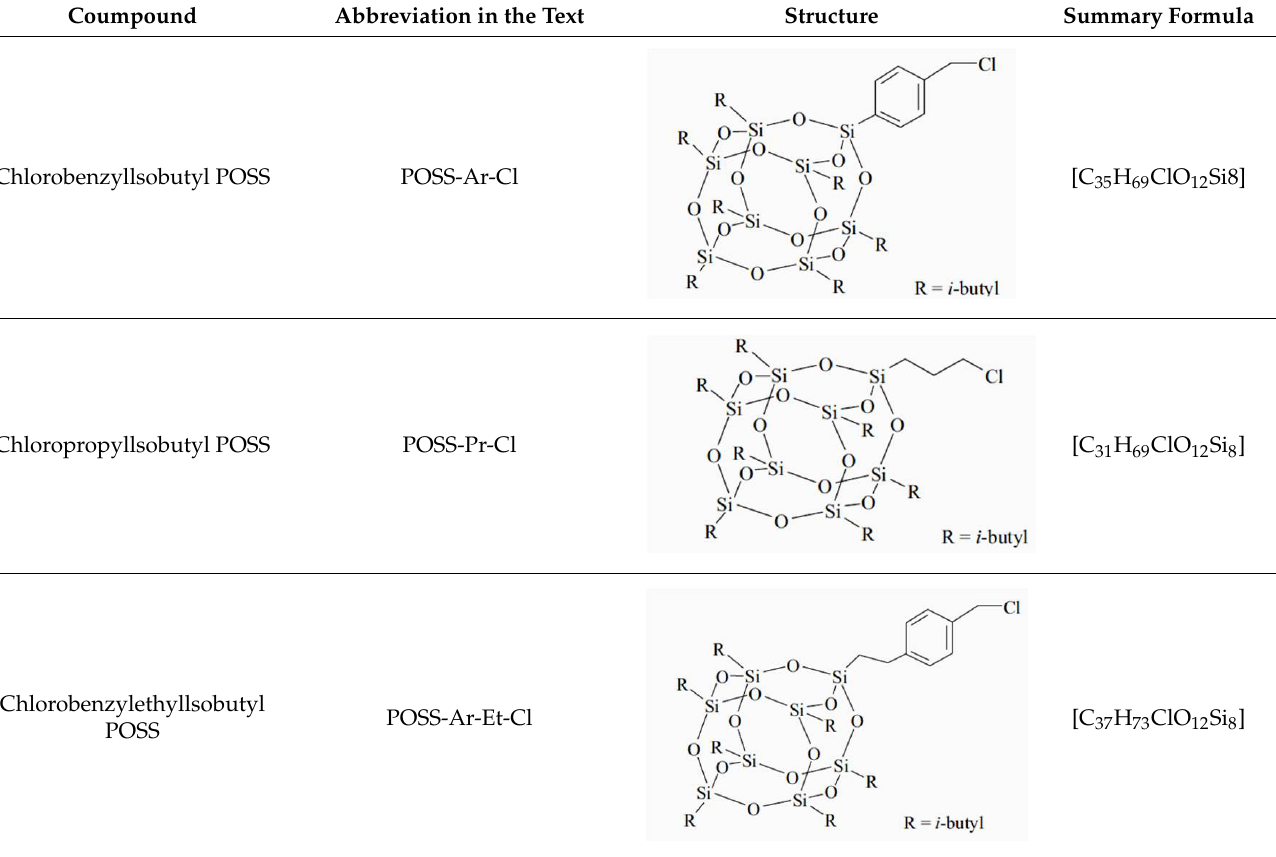
Table 5. POSS-Cl compounds used for modification of PUR foams.